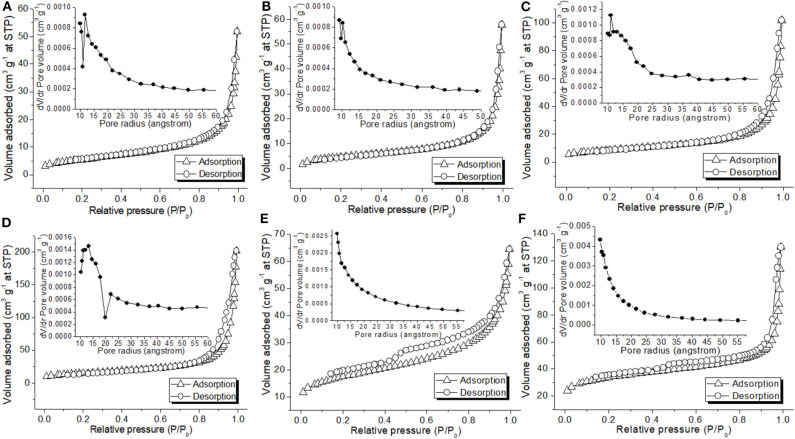
Nitrogen adsorption-desorption isotherm and pore size distribution of (A) C1, (B) C2, (C) C3, (D) C4, (E) C1g, and (F) C4g.